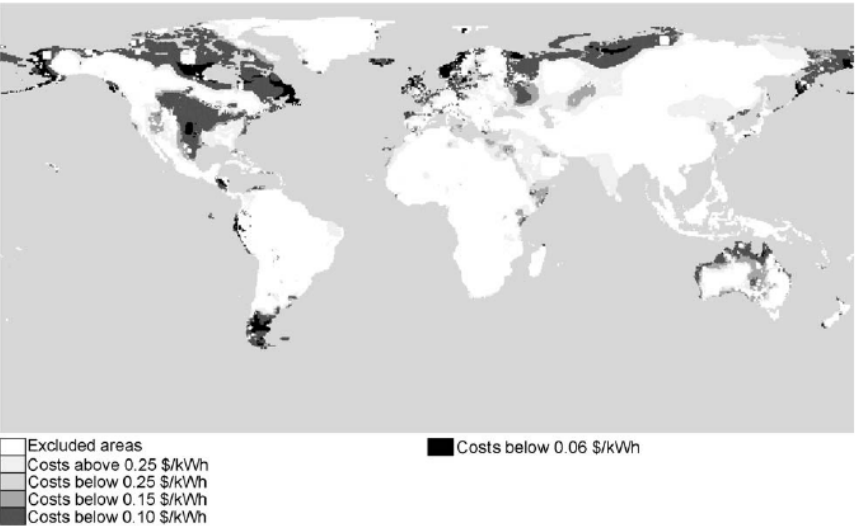
Figure 43. The economic potential of on-shore wind power. © 2004 Elsevier, reproduced with permission from